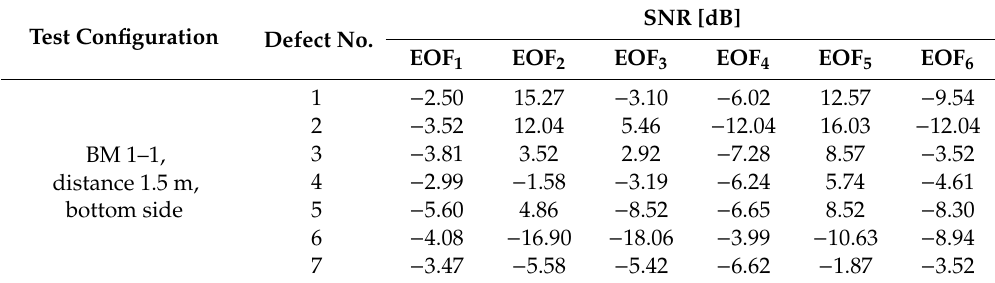
Table 3. SNR values obtained from EOFs presented in Figure 7.